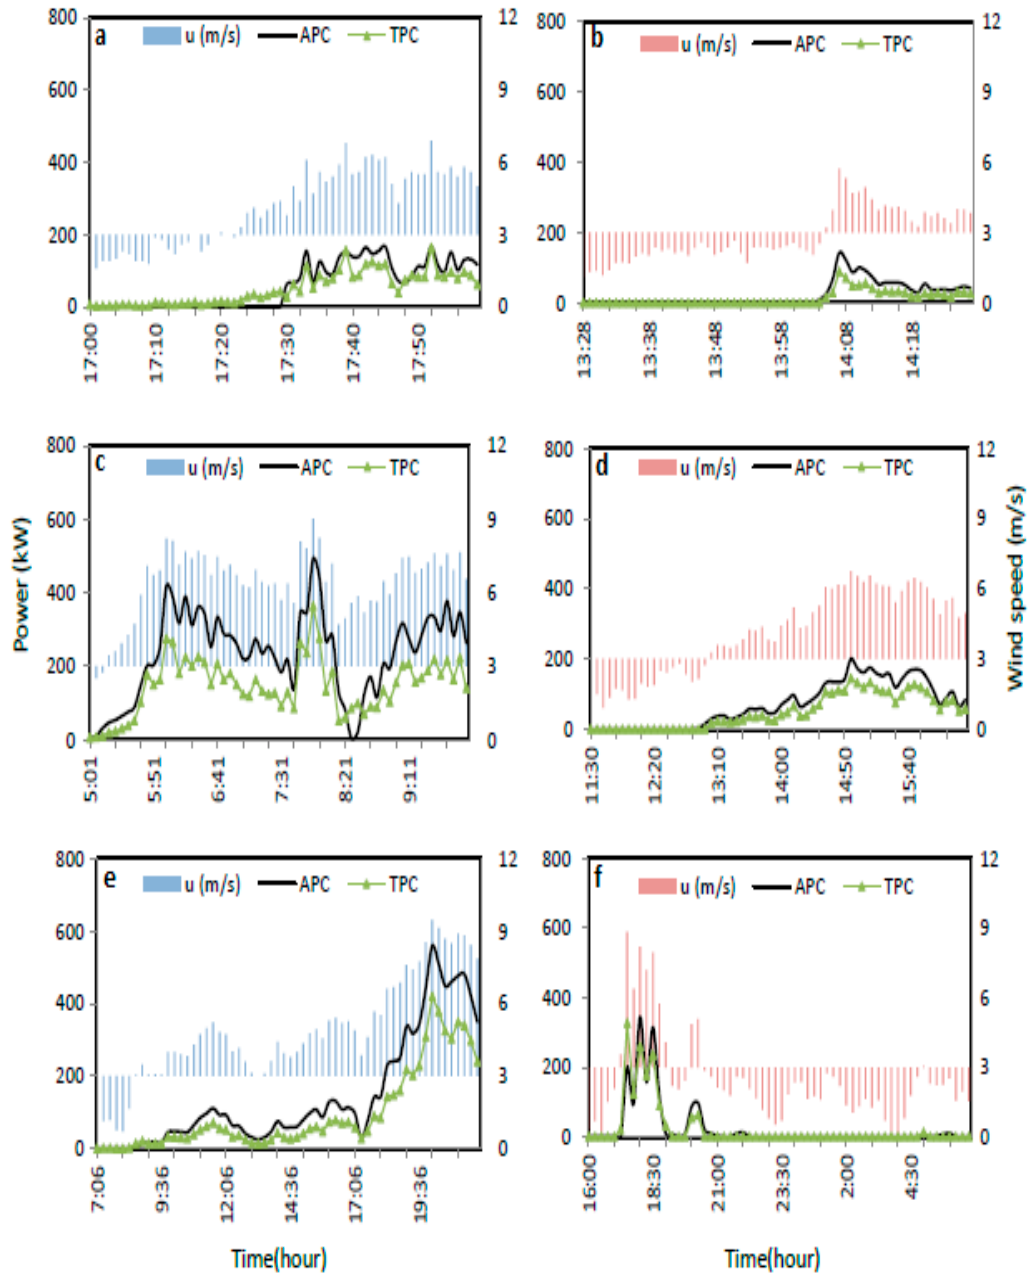
Figure 2. Turbine actual and theoretical power output during scenario B for: 1-min time intervals in ( a ) winter and ( b ) summer; 5-min time intervals in ( c ) winter and ( d ) summer; and 15-min time intervals in ( e ) winter and ( f ) summer, with average wind speed bars inset.